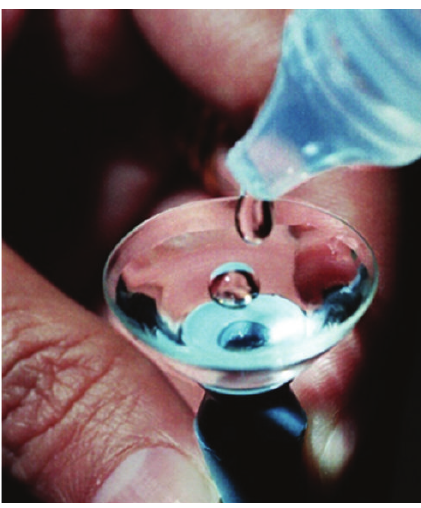
Figure 1: A PROSE device being filled with sterile saline solution.